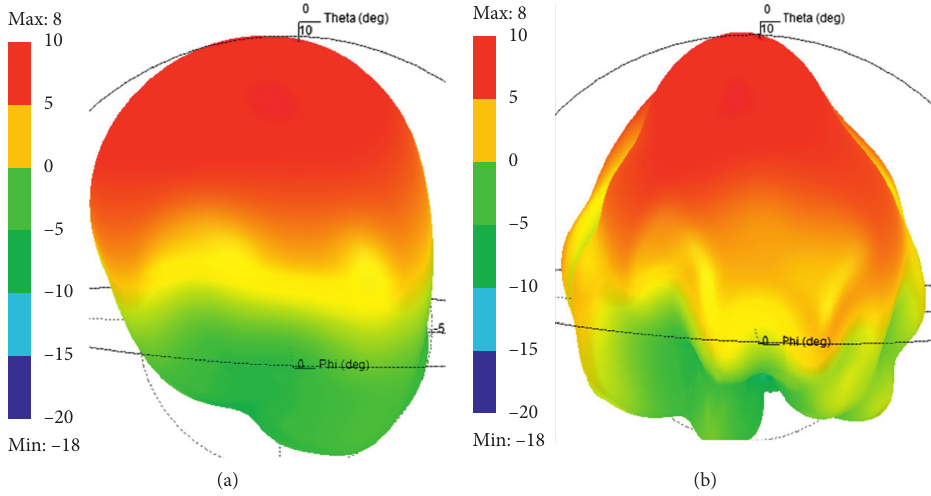
Figure 5: 3D radiation square patch of Design 1: (a) f